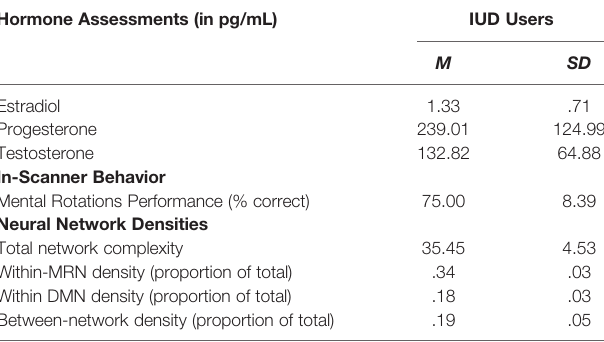
TABLE 1 | Multimodal data for IUD users (n=11): Endogenous hormone levels, mental rotations task performance, and person-speci fi c network densities. Hormone Assessments (in